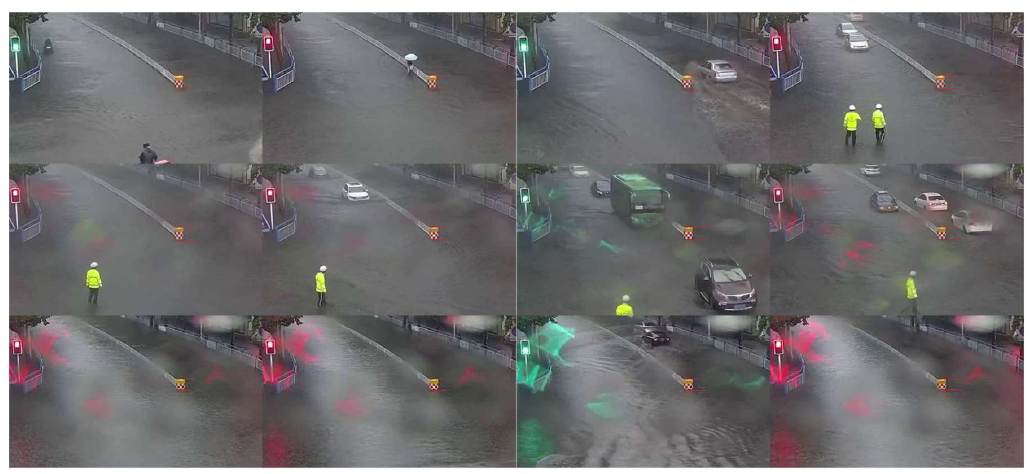
Figure 3. Sample partial images of the video data set.